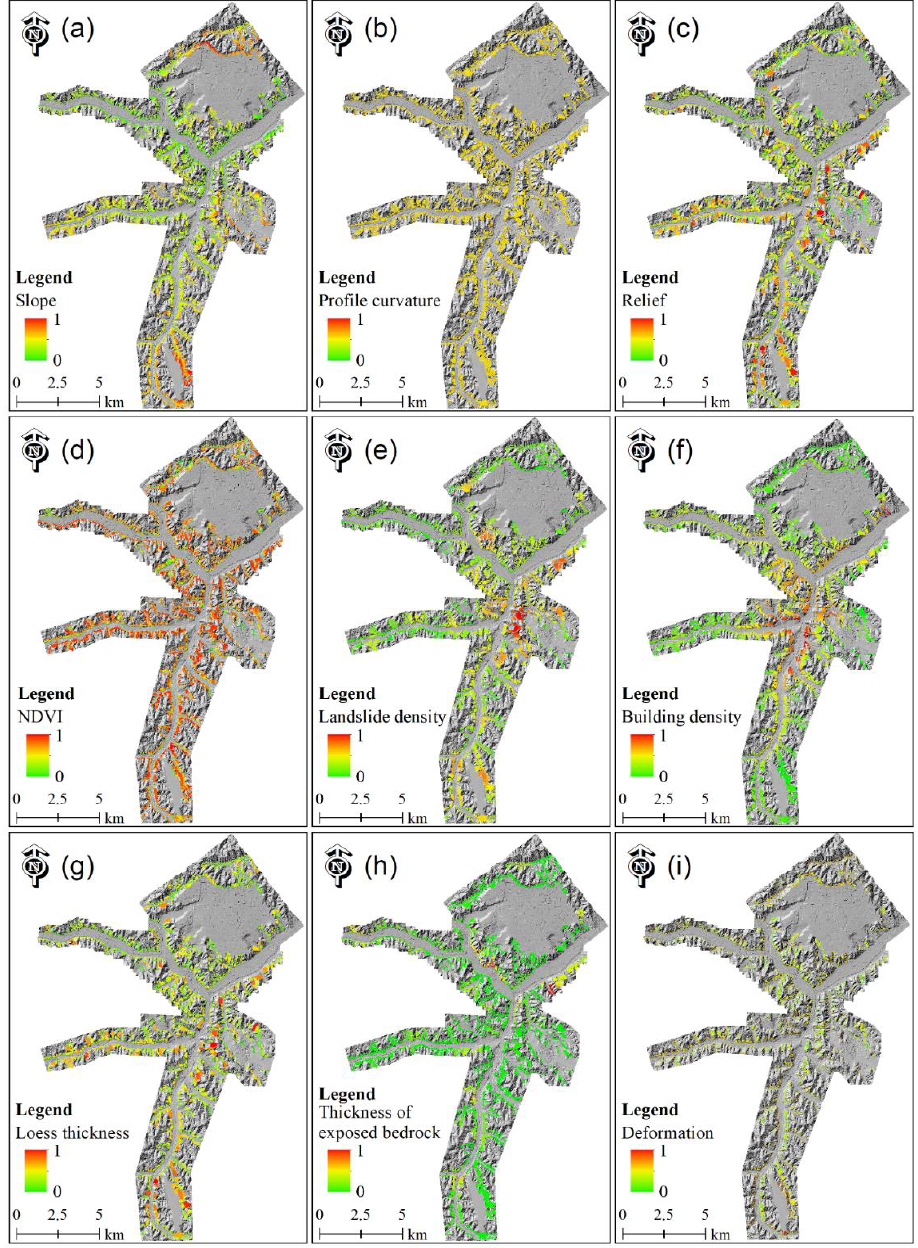
Figure 4. The conditioning factors used in this study: ( a ) slope; ( b ) profile curvature; ( c ) relief; ( d ) NDVI; ( e ) landslide density; ( f ) building density; ( g ) loess thickness; ( h ) thickness of exposed bedrock; and ( i ) deformation. The above parameters have been normalized. Table 1. Statistical description of the influencing factors.